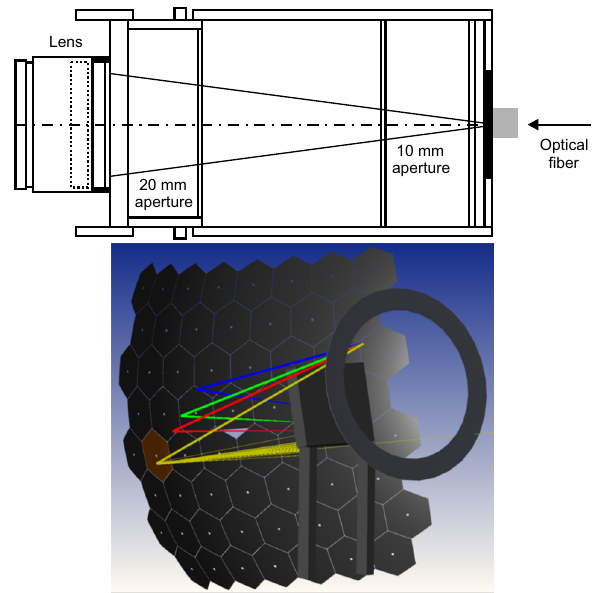
Figure 7. Top: the schematics of the optical collimator. Bottom: the layout of the optical simulation showing several light beams of the optical collimator reflecting on the FD telescope